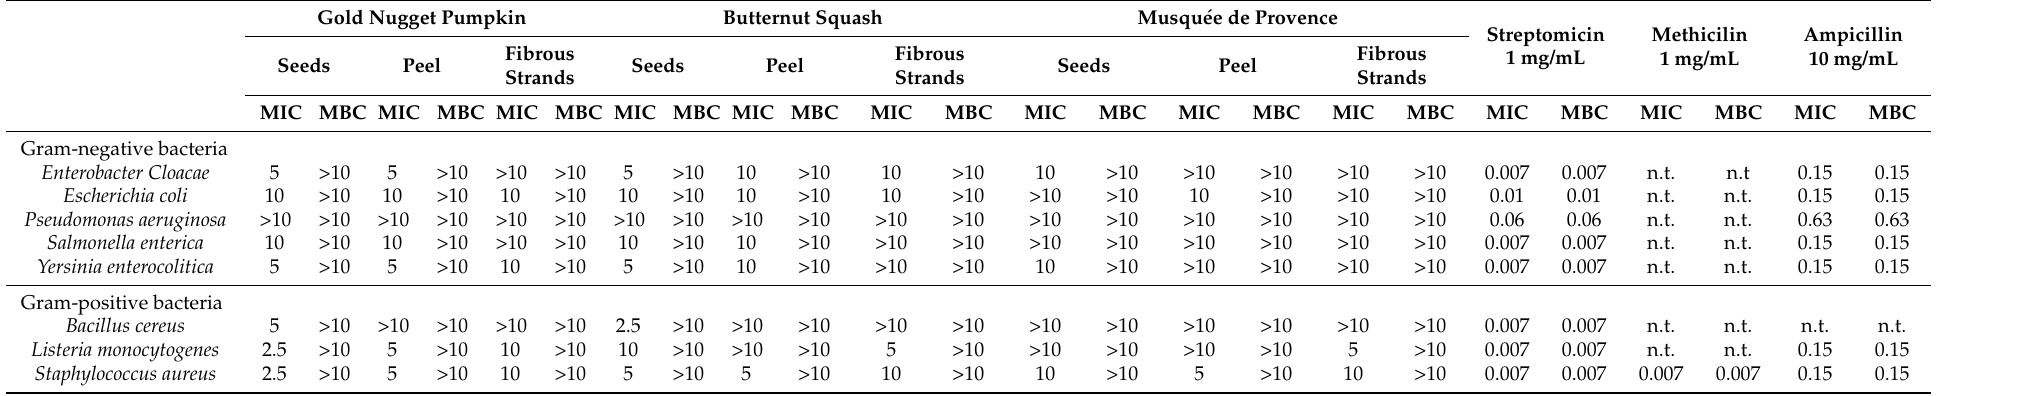
Table 8. Antibacterial activity of the byproducts of three pumpkin genotypes from Algeria. Gold Nugget Pumpkin